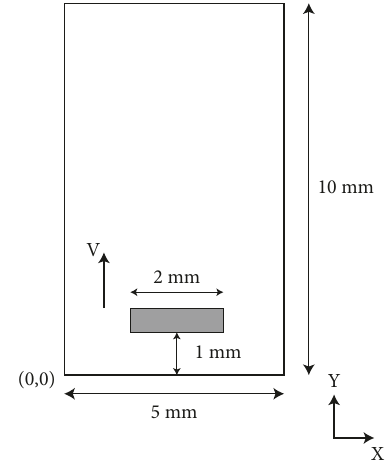
Figure 8: Two-plane two-dimensional model.